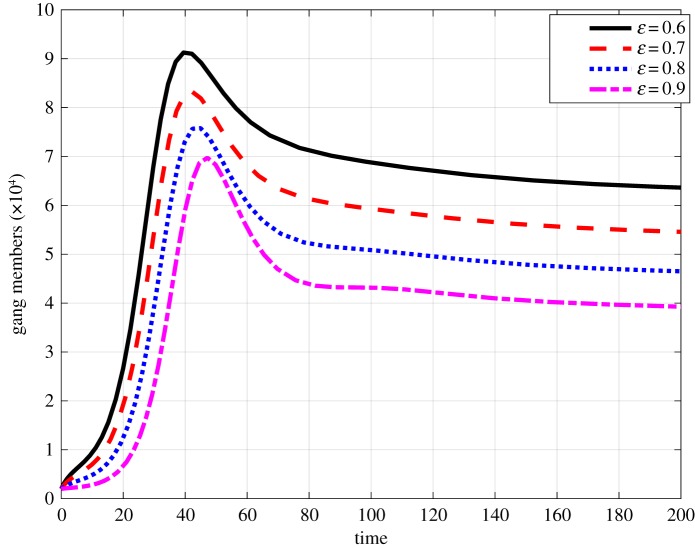
Impactof varying of ε on the prevalence of gang members where the time is in months.